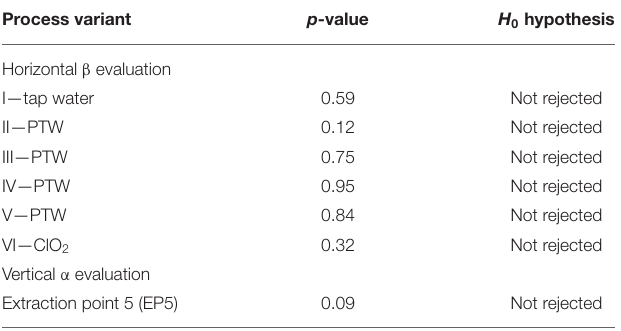
TABLE 4 | Statistical evaluation of storage day 7.